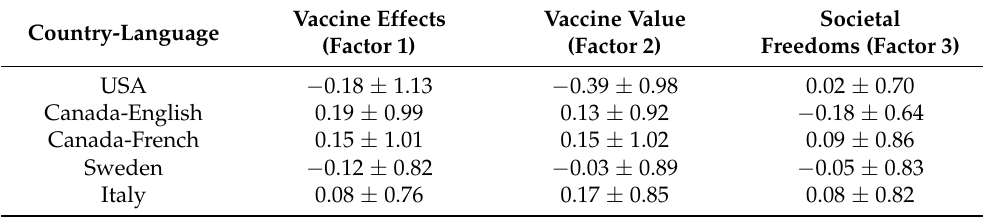
Table 3. Estimated Person Ability Scores by Country-language groups with no DIF items.